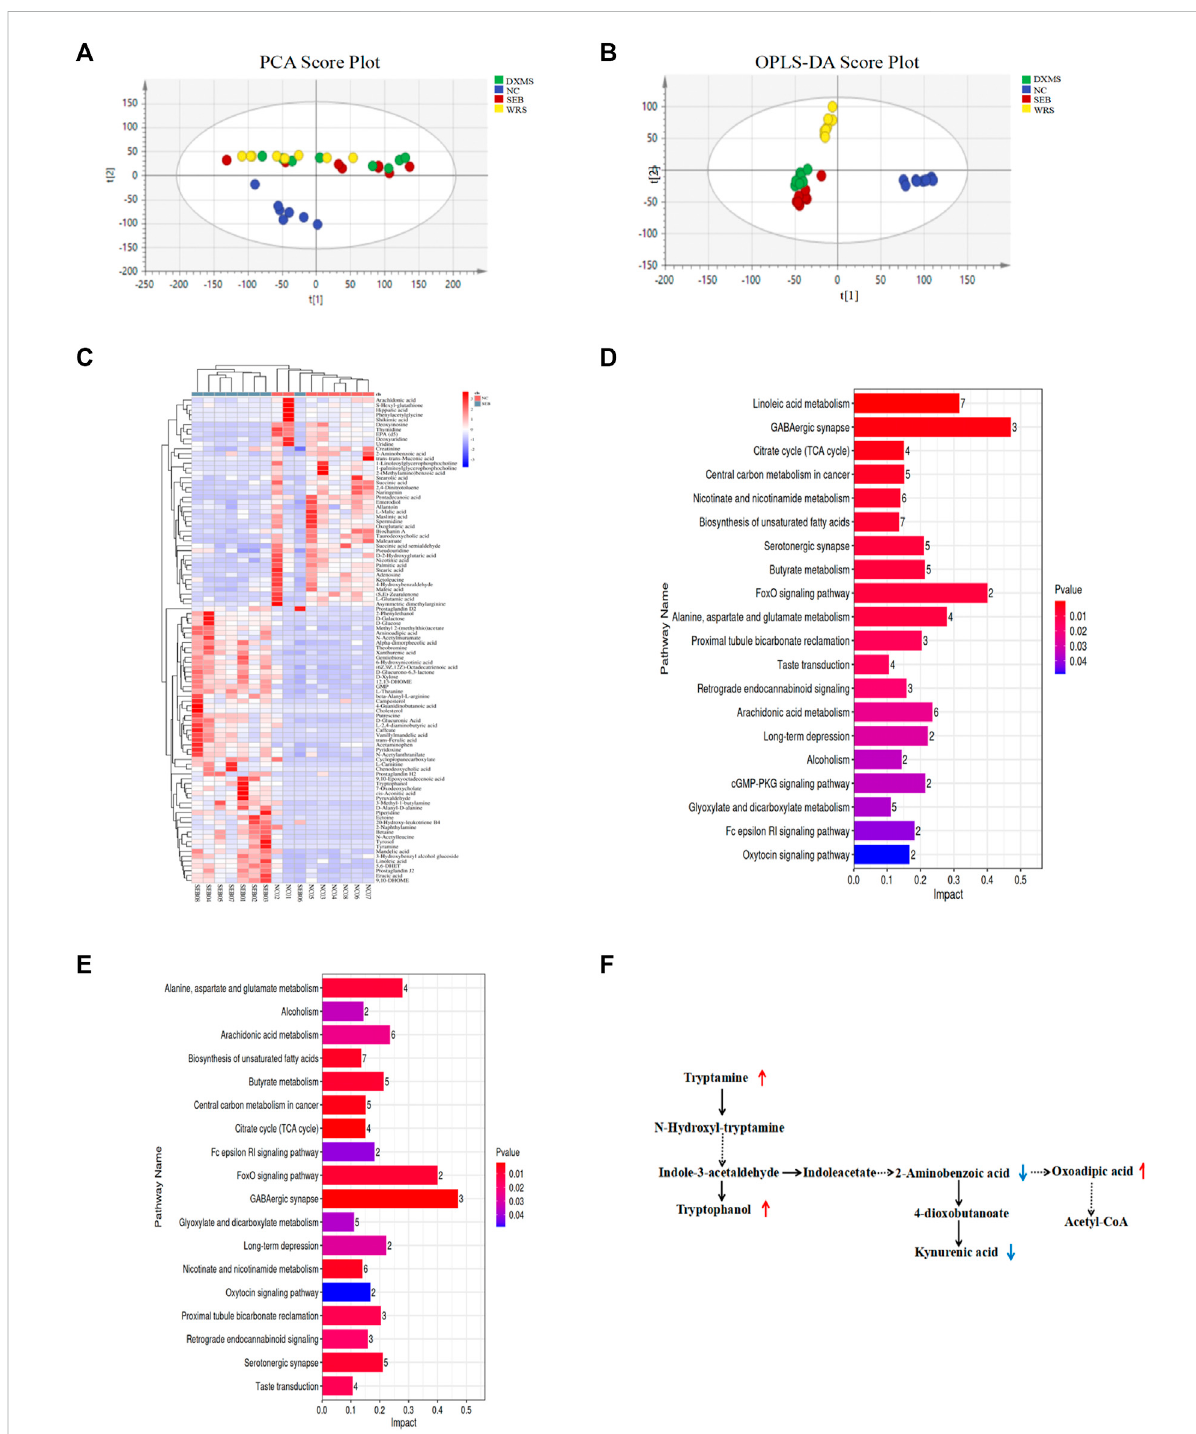
FIGURE 5 Effect of WRS on fecal metabolites in mice with SEB infection. (A) PCA plot. (B) OPLS-DA plot. (C) Differential metabolites between NC group andSEBgroup. (D) ChangesofmetabolicpathwayenrichmentbetweenNCandSEBgroups. (E) Changesofmetabolicpathwayenrichmentbetween SEB and WRS groups. (F) Correlation among differential metabolites involved in tryptophan metabolism. Data have been presented as means ± SD ( n = 8). Statistical analysis was carried out using one-way ANOVA. * p < 0.05, ** p < 0.01, *** p <